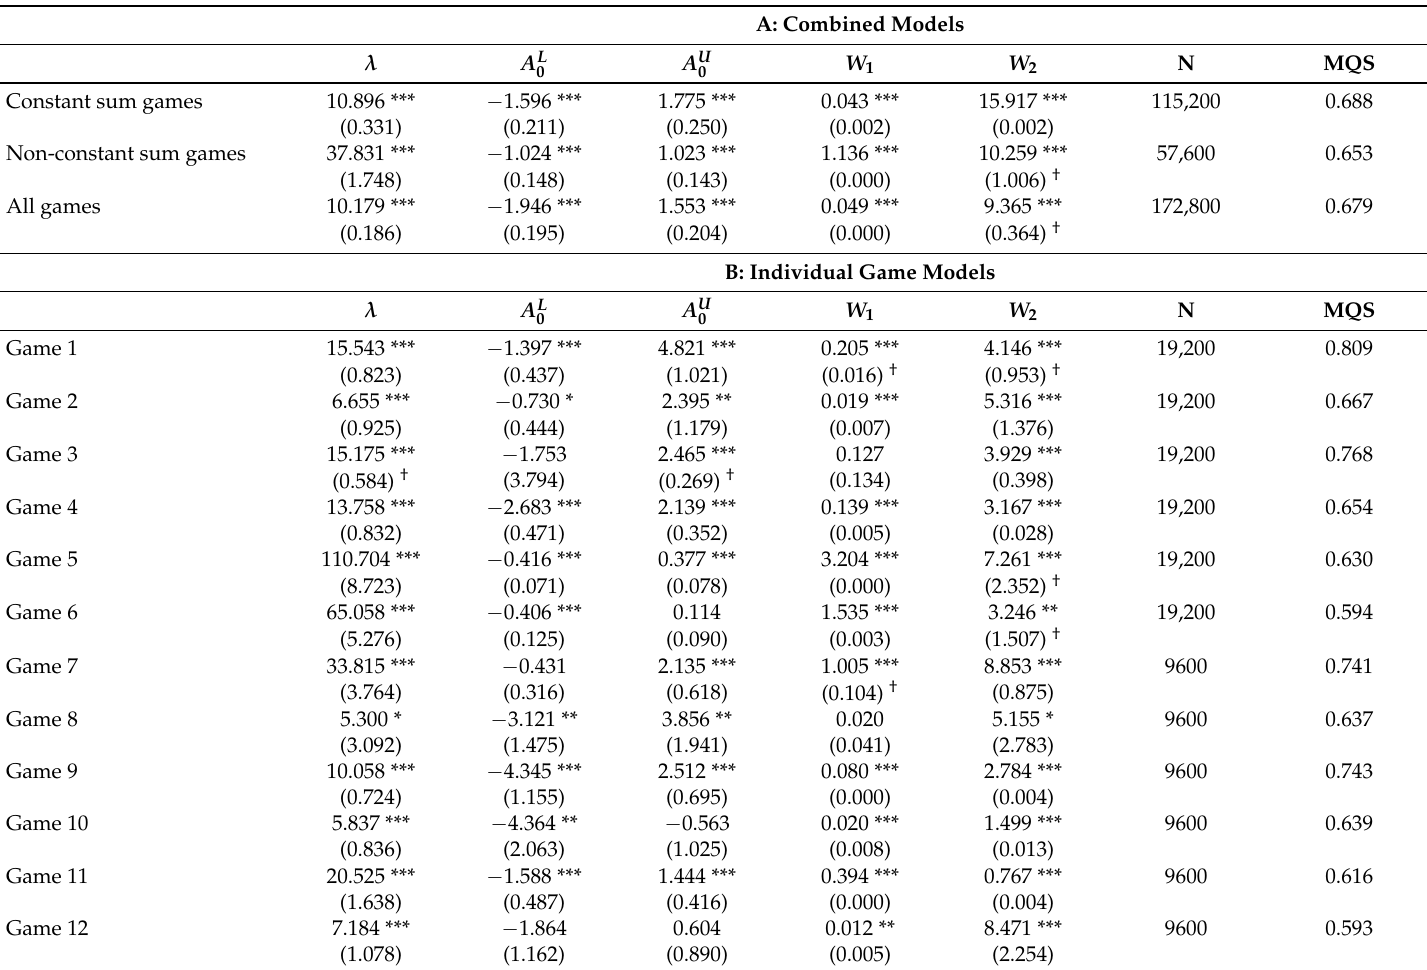
Table 1. CBL Parameter Estimates. Note: ***, **, * denote statistical significance of 10%, 5%, and 1%. Clustered standard errors by subject are in parentheses. MQS is the mean quadratic score. † The standard error did not calculate using clustered standard errors and is instead calculated using the outer product of the gradient (OPG) vectors